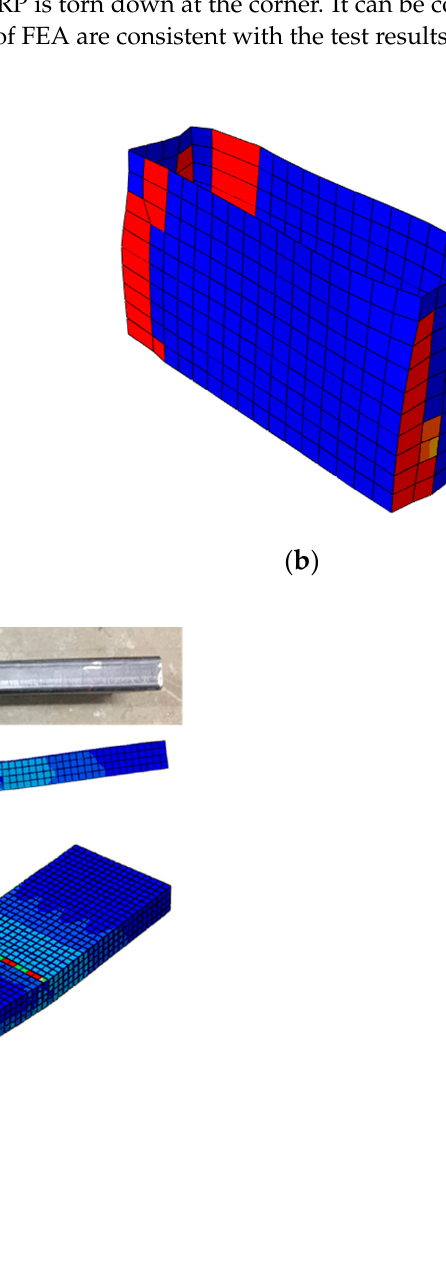
Table 9. Design parameter variables.